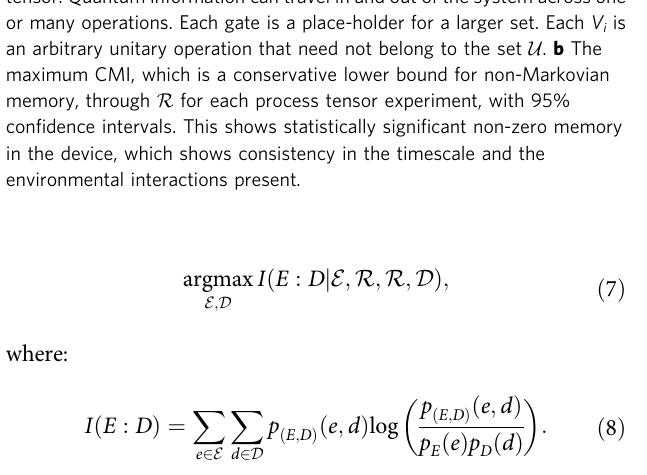
Fig. 4 Comparison with a Markov model. We benchmark the accuracy with which different techniques can predict the outcome of a given process for 64 circuits. When nearby qubits are initialised as 0 j i , the median fi delity from GST is similar to the process tensor in each scenario. When the neighbouring qubits are in state þj i , however, GST suffers from a fi delity drop of about 1.2%. This is a demonstration of how a technique like the process tensor could complement existing characterisation techniques in realistic non-Markovian